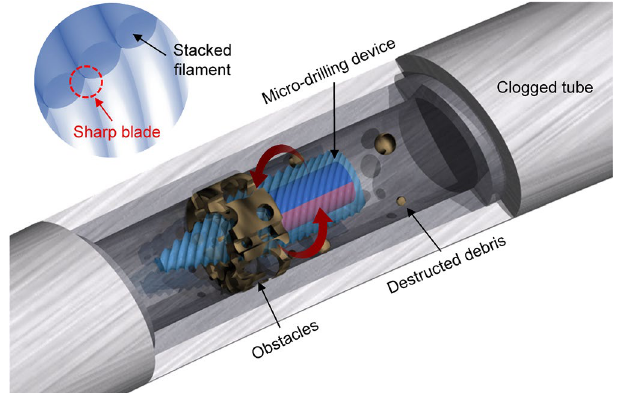
Figure 1. Schematic of the micro-drilling device which destroys the clogged materials in a tube such as blood vessel or water supply line. Inset: formation of sharp waveform blades by the staircase effect between stacked